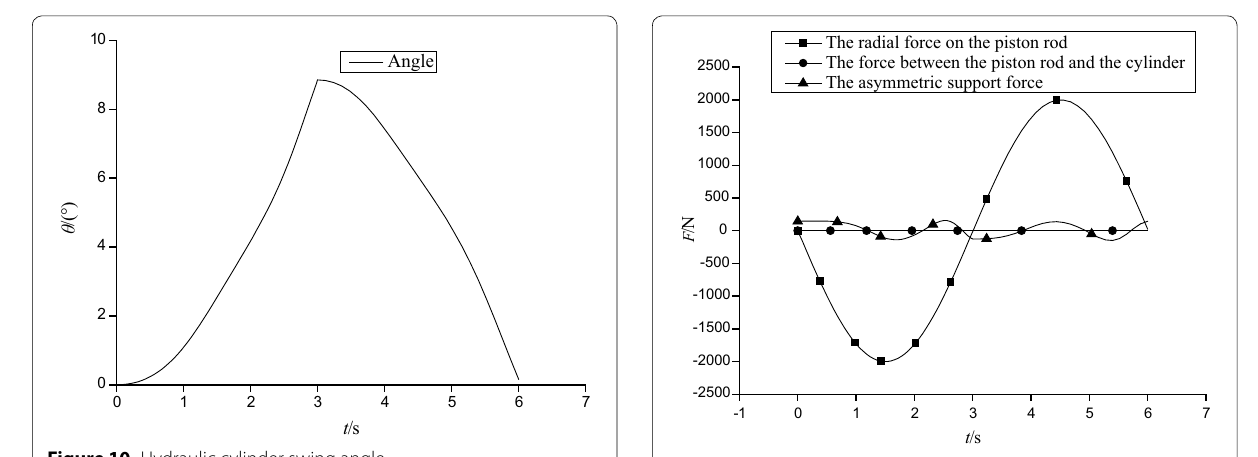
Figure 11 Asymmetric hydrostatic support structure stress